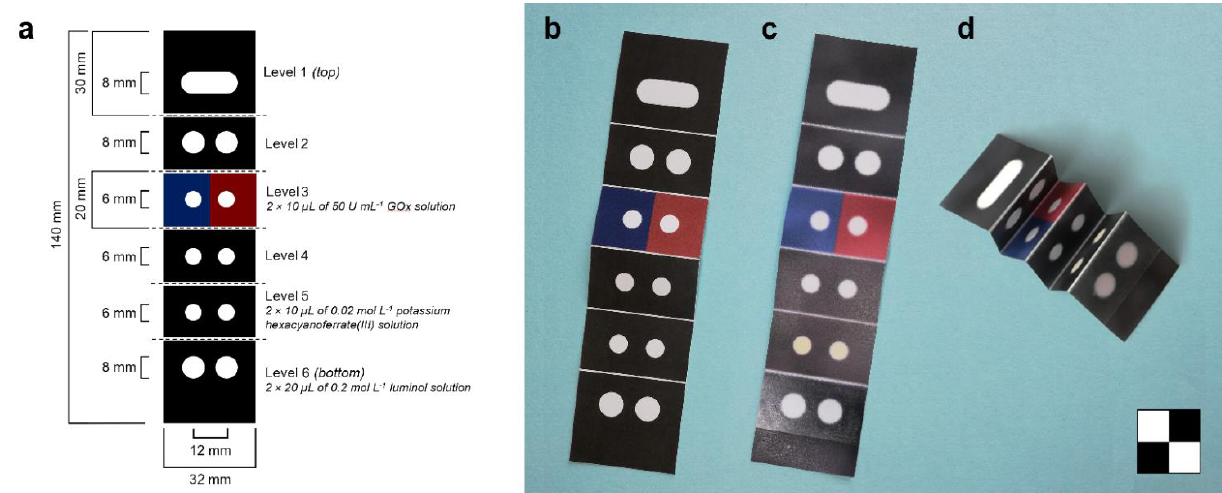
Figure 1. ( a ) Printing scheme of the origami µPAD with indication of the preloaded reagents (the red and blue areas indicate the loading positions of the sample and of the glucose standard solution, respectively). The dashed segments indicate the fold lines; ( b ) origami µPAD before heating to generate hydrophobic areas; ( c ) origami µPAD after heating, with preloaded reagents and applied clear adhesive tape; ( d ) origami µPAD folded for insertion into the biosensor holder. The chessboard is 2 × 2 cm 2 .